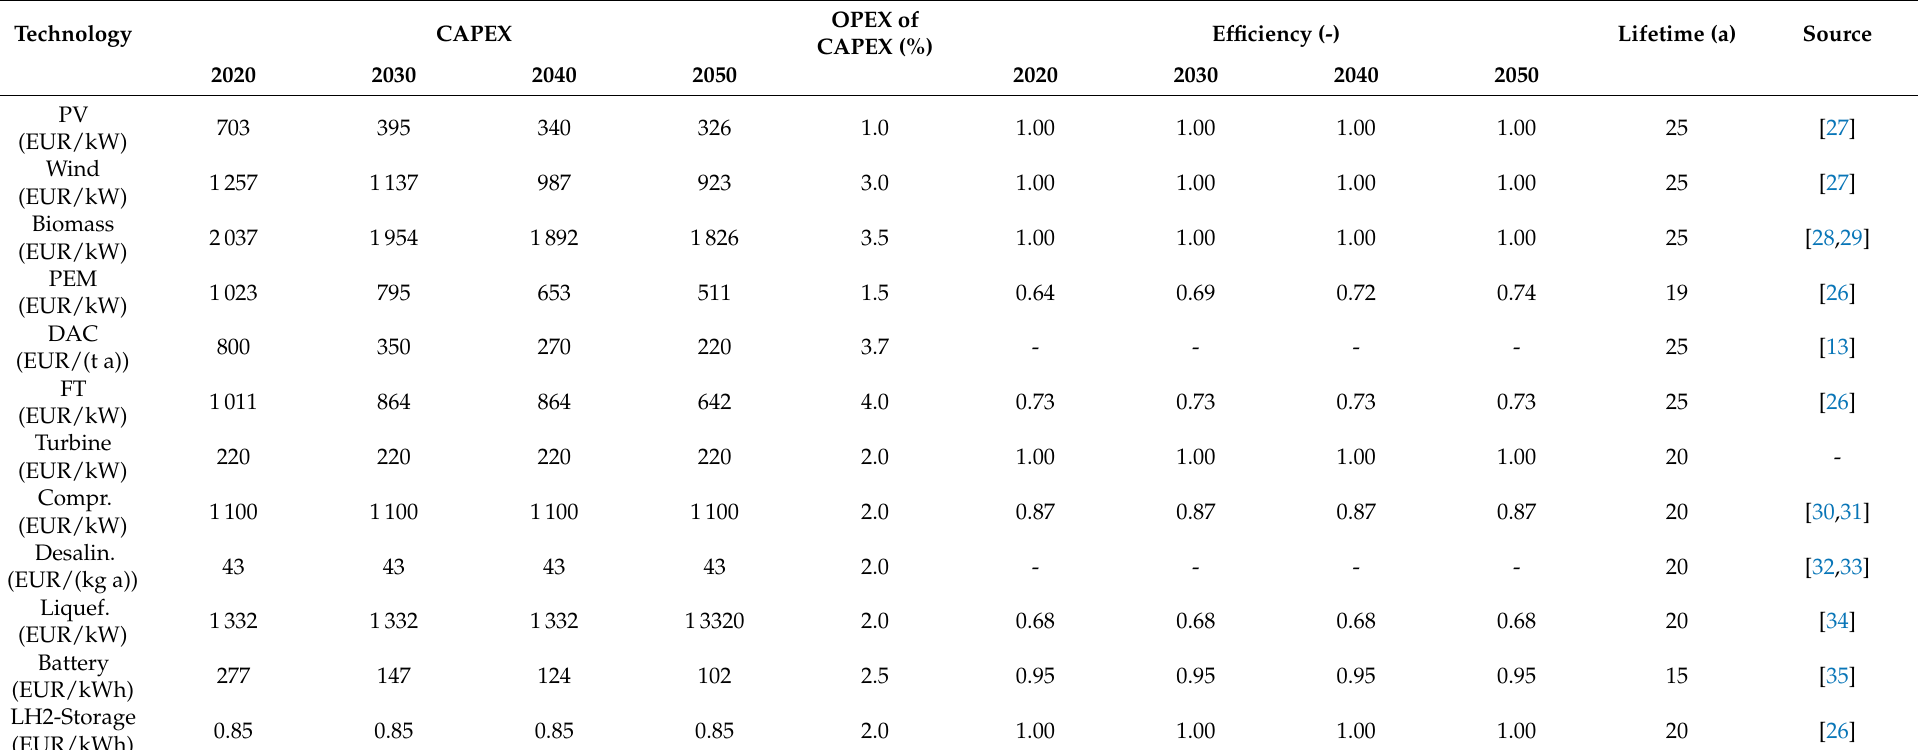
Table 1. Technology costs and